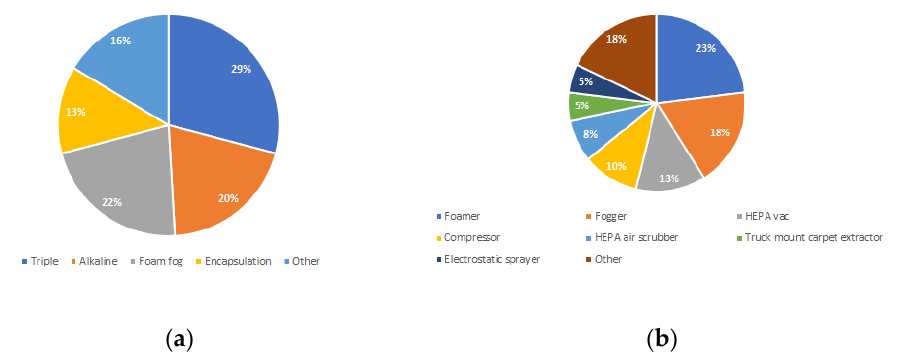
Figure 3. ( a ) Remediation methods used; ( b ) equipment used to remediate methamphetamine contamination.